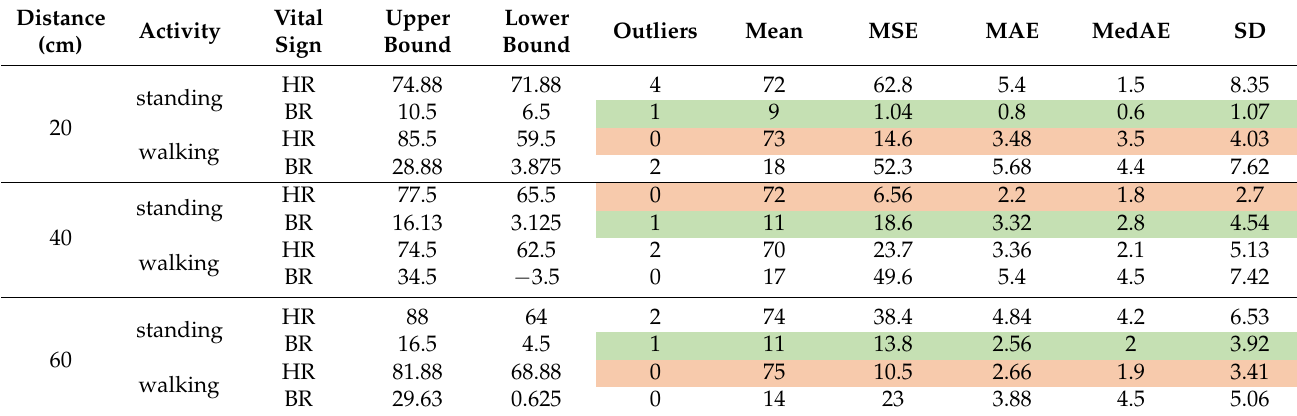
Table 5. Statistical evaluation of effect of movement.